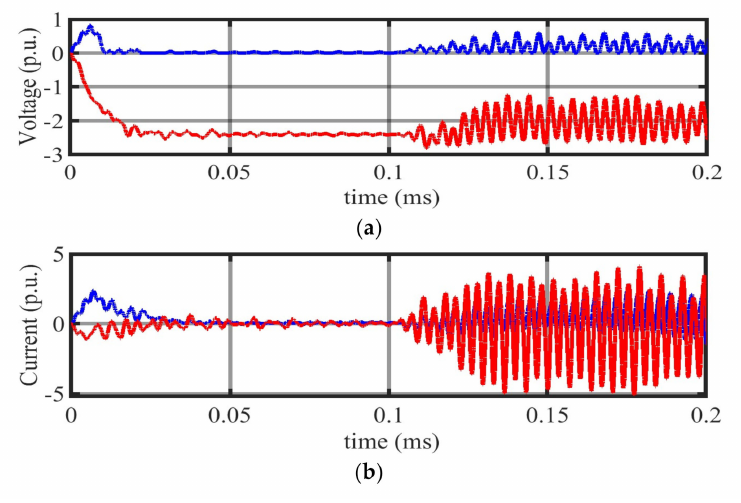
Figure 24. ( a ) DC Voltage and ( b ) DC current measured under PPG fault occurred 200 km from RS-I Line